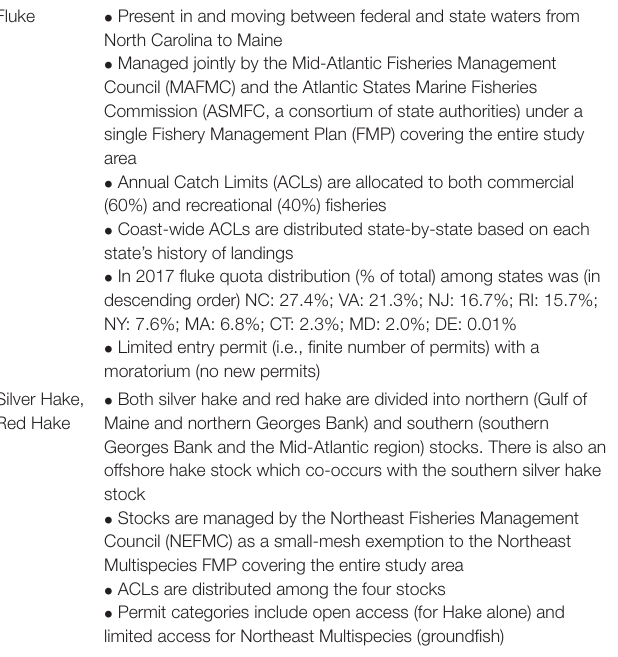
TABLE 1 | Overview of management measures for fluke and hake